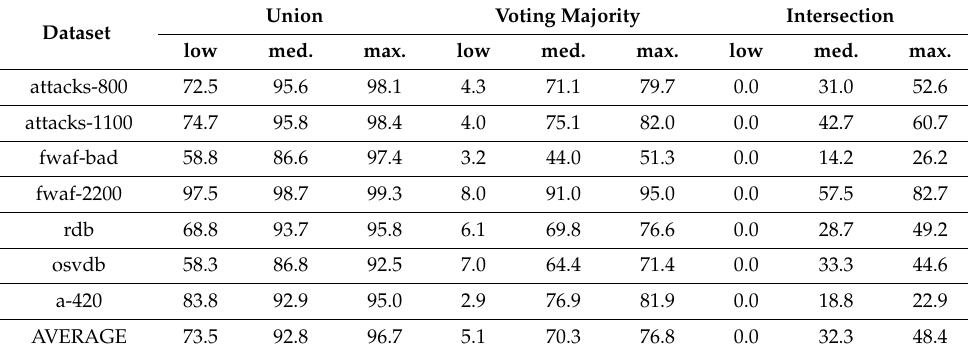
Table 4. Detection rate or recall (percentage) with a cooperative